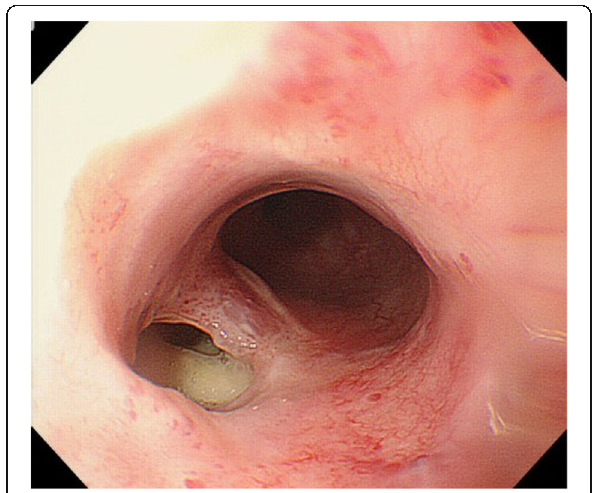
Fig. 1 Endoscopy revealed an esophageal perforation in the left side of the upper thoracic esophagus